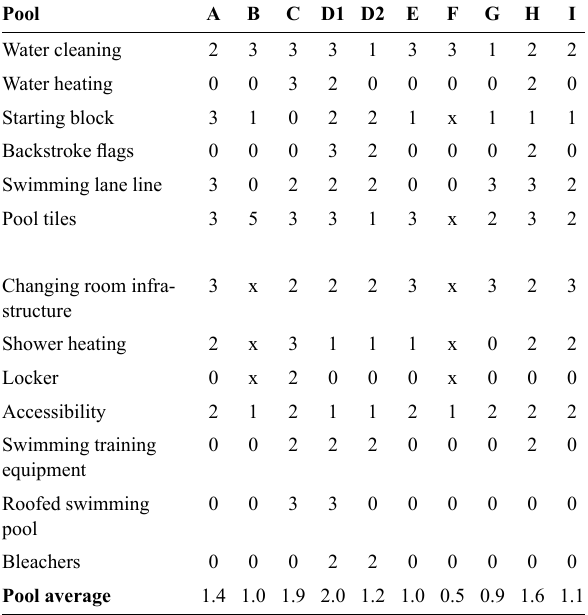
Table 3 - Infrastructure conditions for public swimming pools in Lime- ira, SP. Source: own elaboration.